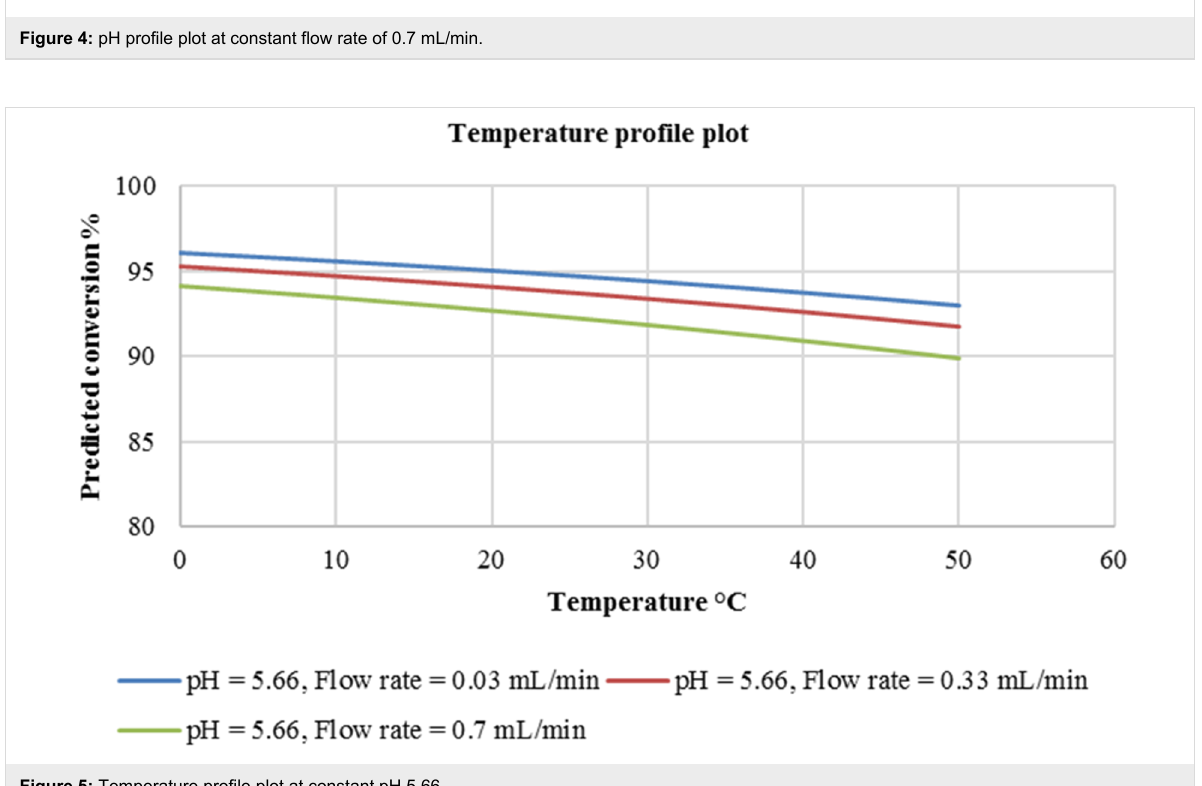
Figure 4: pH profile plot at constant flow rate of 0.7 mL/min.